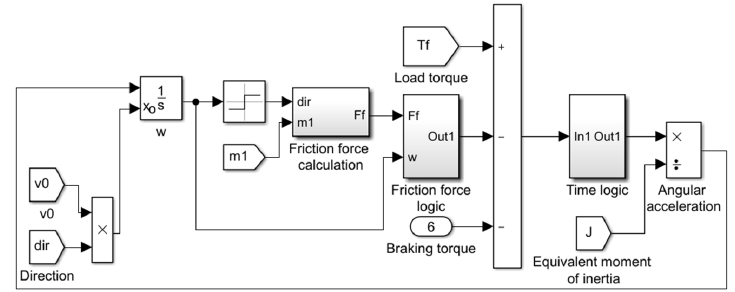
Figure 9. Rotational dynamic model sub ‐ module of connecting shaft.